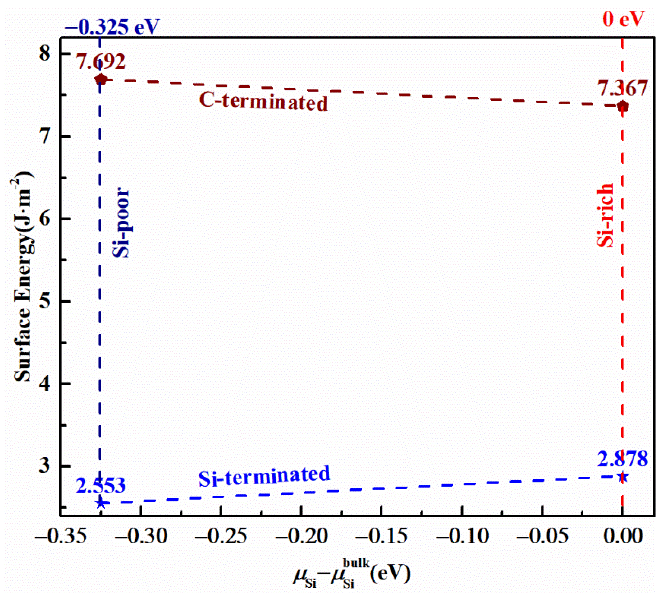
Figure 2. Surface energy of 6H-SiC(0001) with respect to Si chemical potential change.